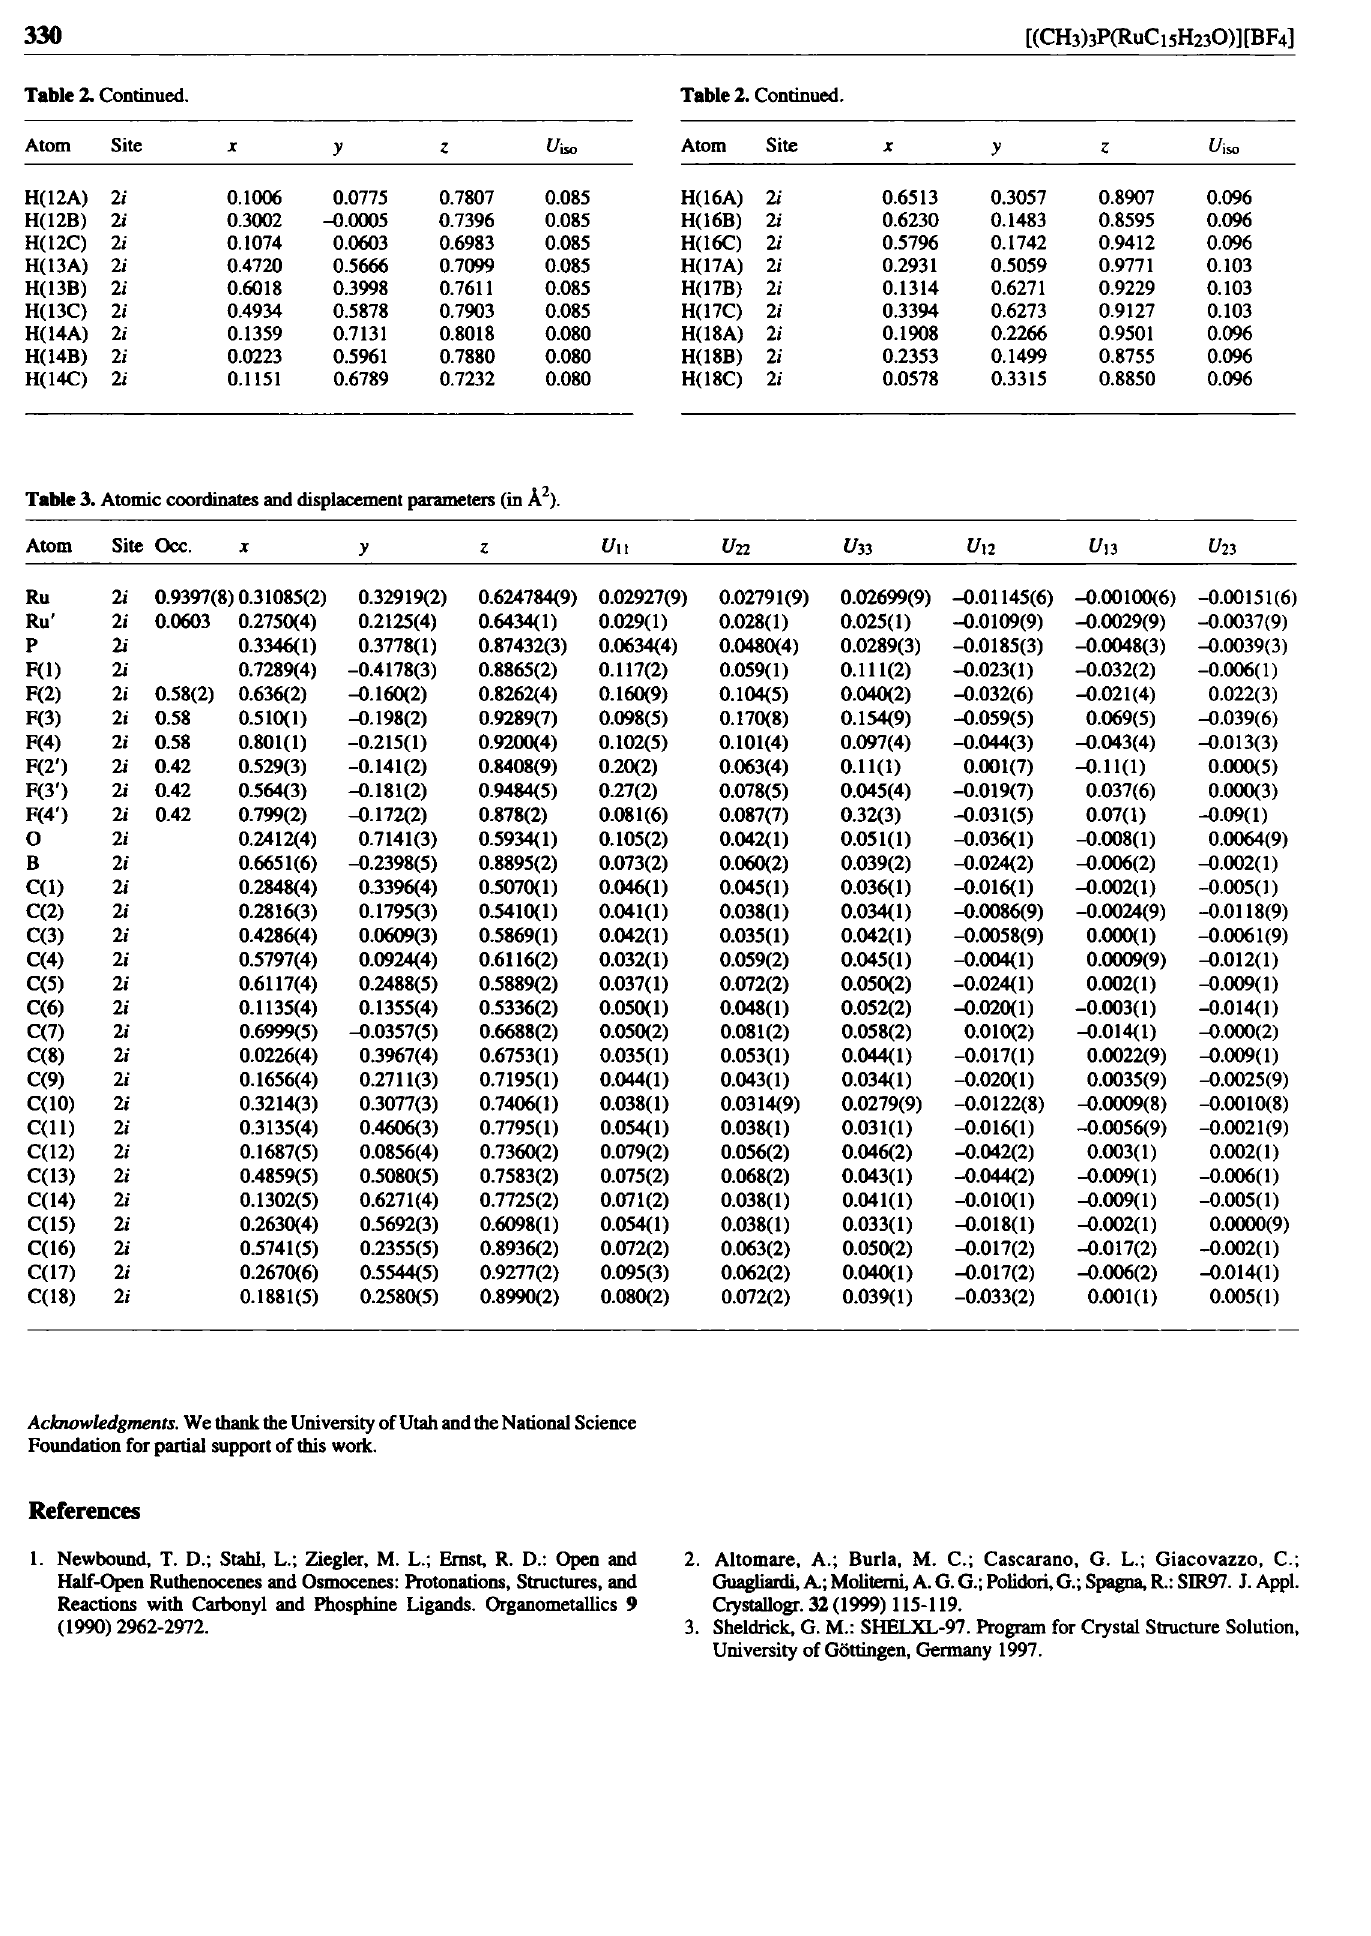
Table 3. Atomic coordinates and displacement parameters (in À 2 ). Atom Site